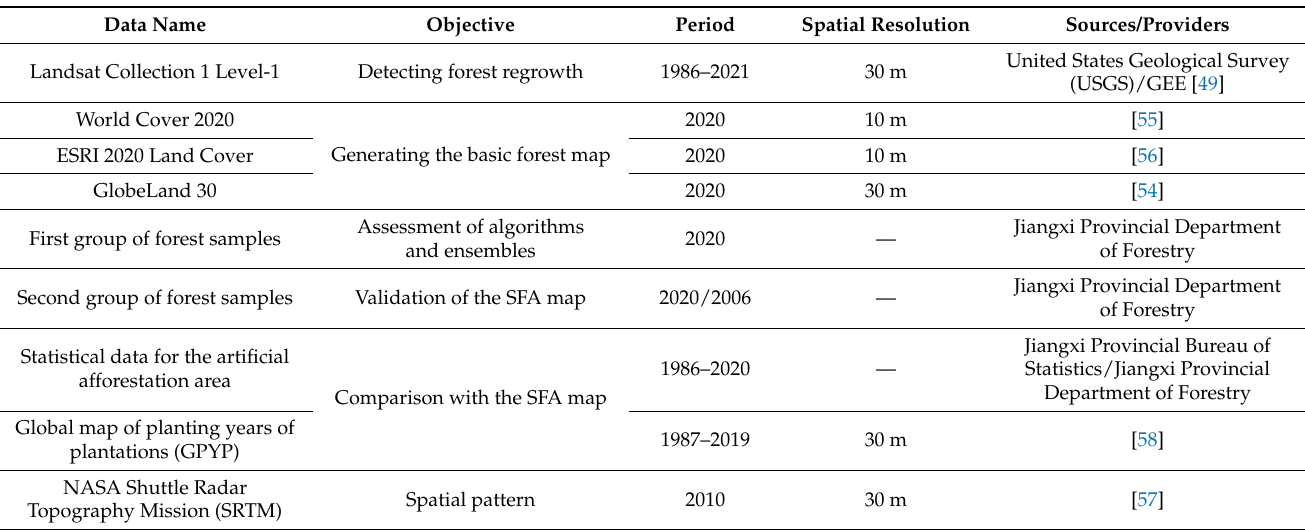
Table A1. The list of datasets used in this study.